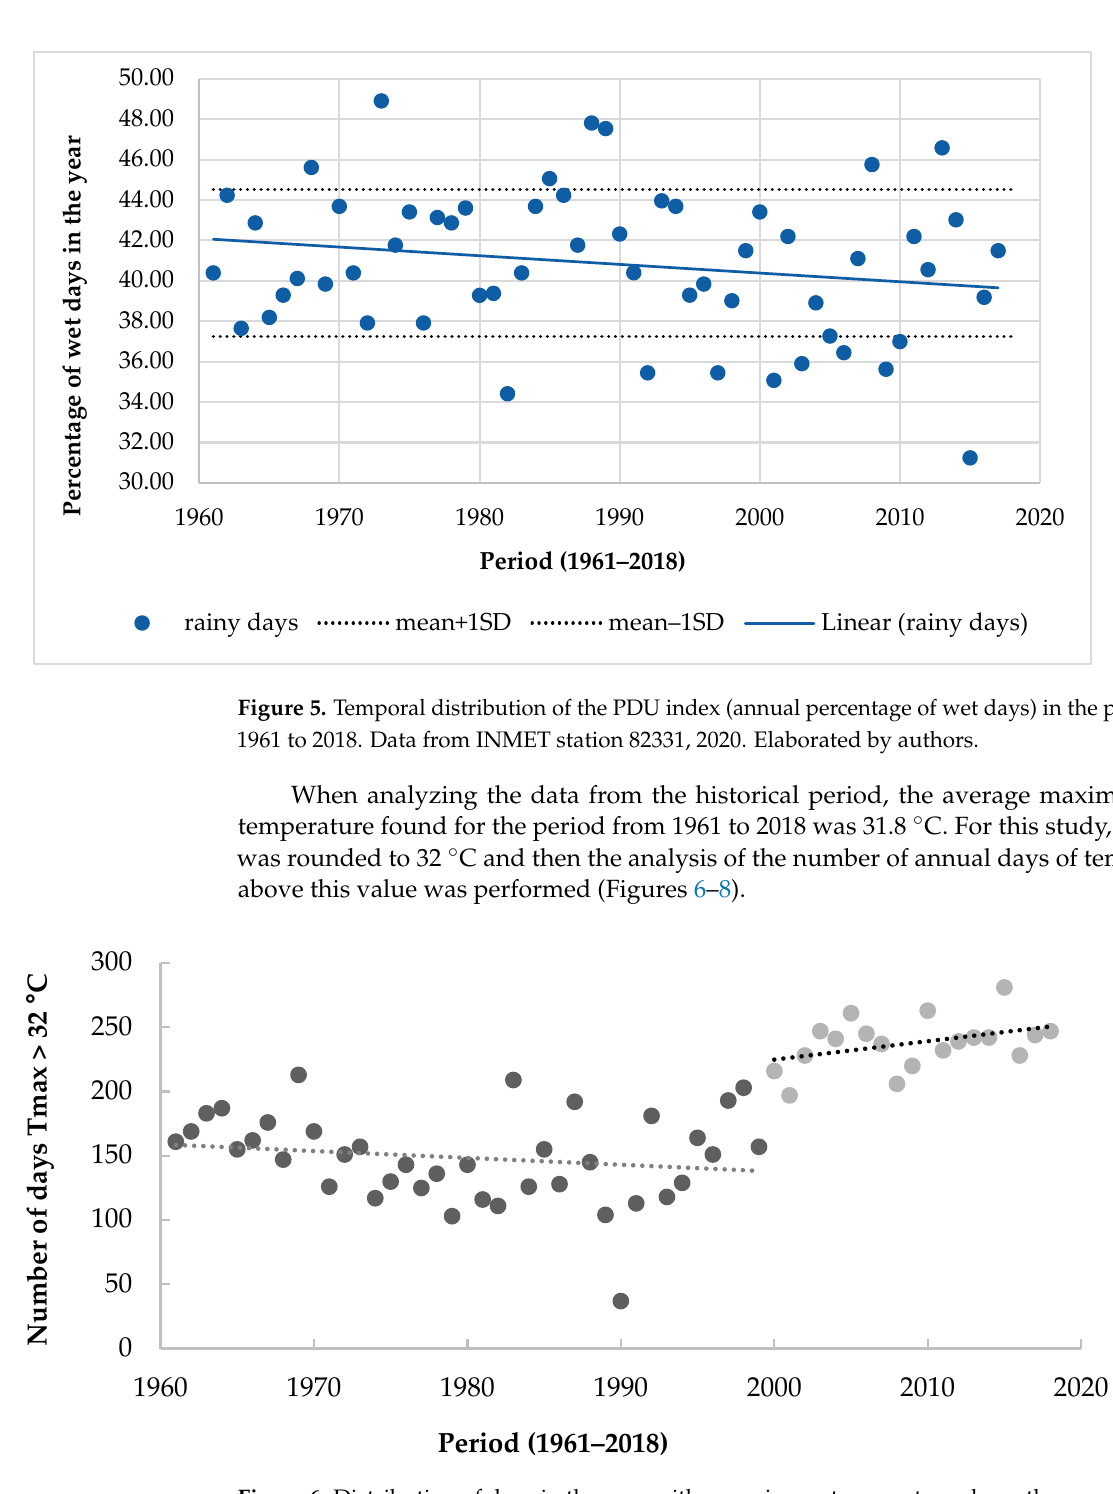
from 1961 to 2018 (Figure 5). There was a decrease in the number of wet days after 1990,